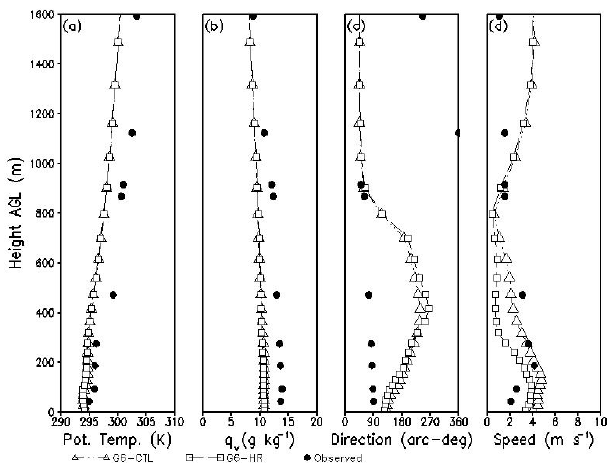
Figure 13. Vertical data profiles of (a) θ (K), (b) q v (gkg − 1 ) , (c) wind direction (arc-deg) and (d) speed (ms − 1 ) observed (closed circle) and simulated by G6 of the CTL (open triangle) and HR (open square) runs for 12:00UTC 6 September 2007 at SBGL upper-air weather-observation station.